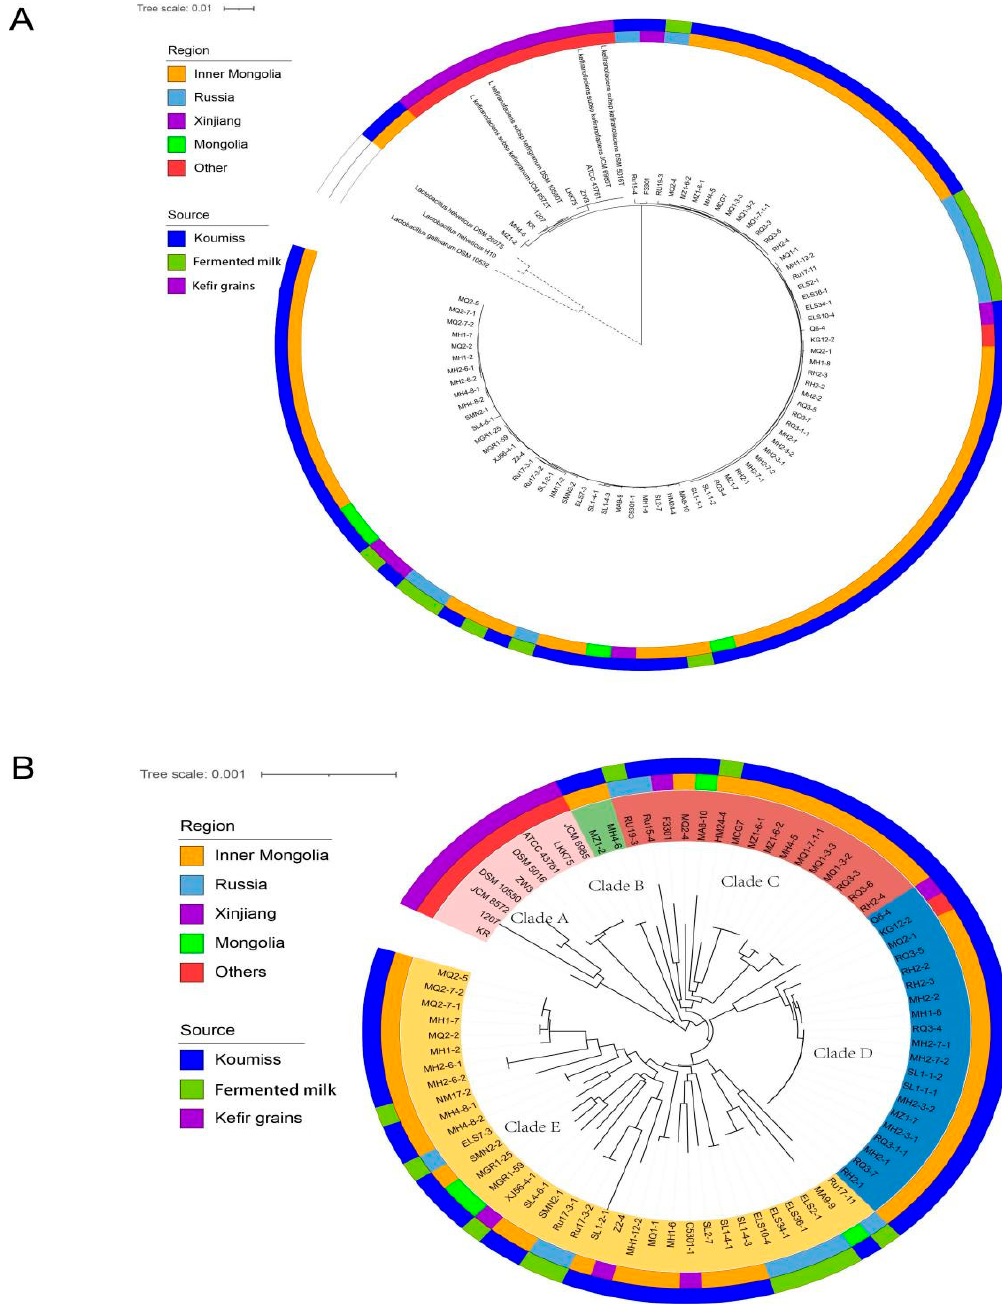
Figure 2. Phylogenetic trees constructed based on 1045 core genes in 82 L. kefiranofaciens strains. Constructing phylogenetic tree based on 1045 core genes of 82 strains of Lactobacillus kefiranofaciens , The Lactobacillus helveticus DSM 20075 T , the Lactobacillus helveticus H10 and the Lactobacillus gallinarum DSM 10532 T were used as outgroups ( A ). ( B ) depicts the isolation information of 82 strains, with the inner layer marking the location of strain isolation and the outer layer marking the source of strain